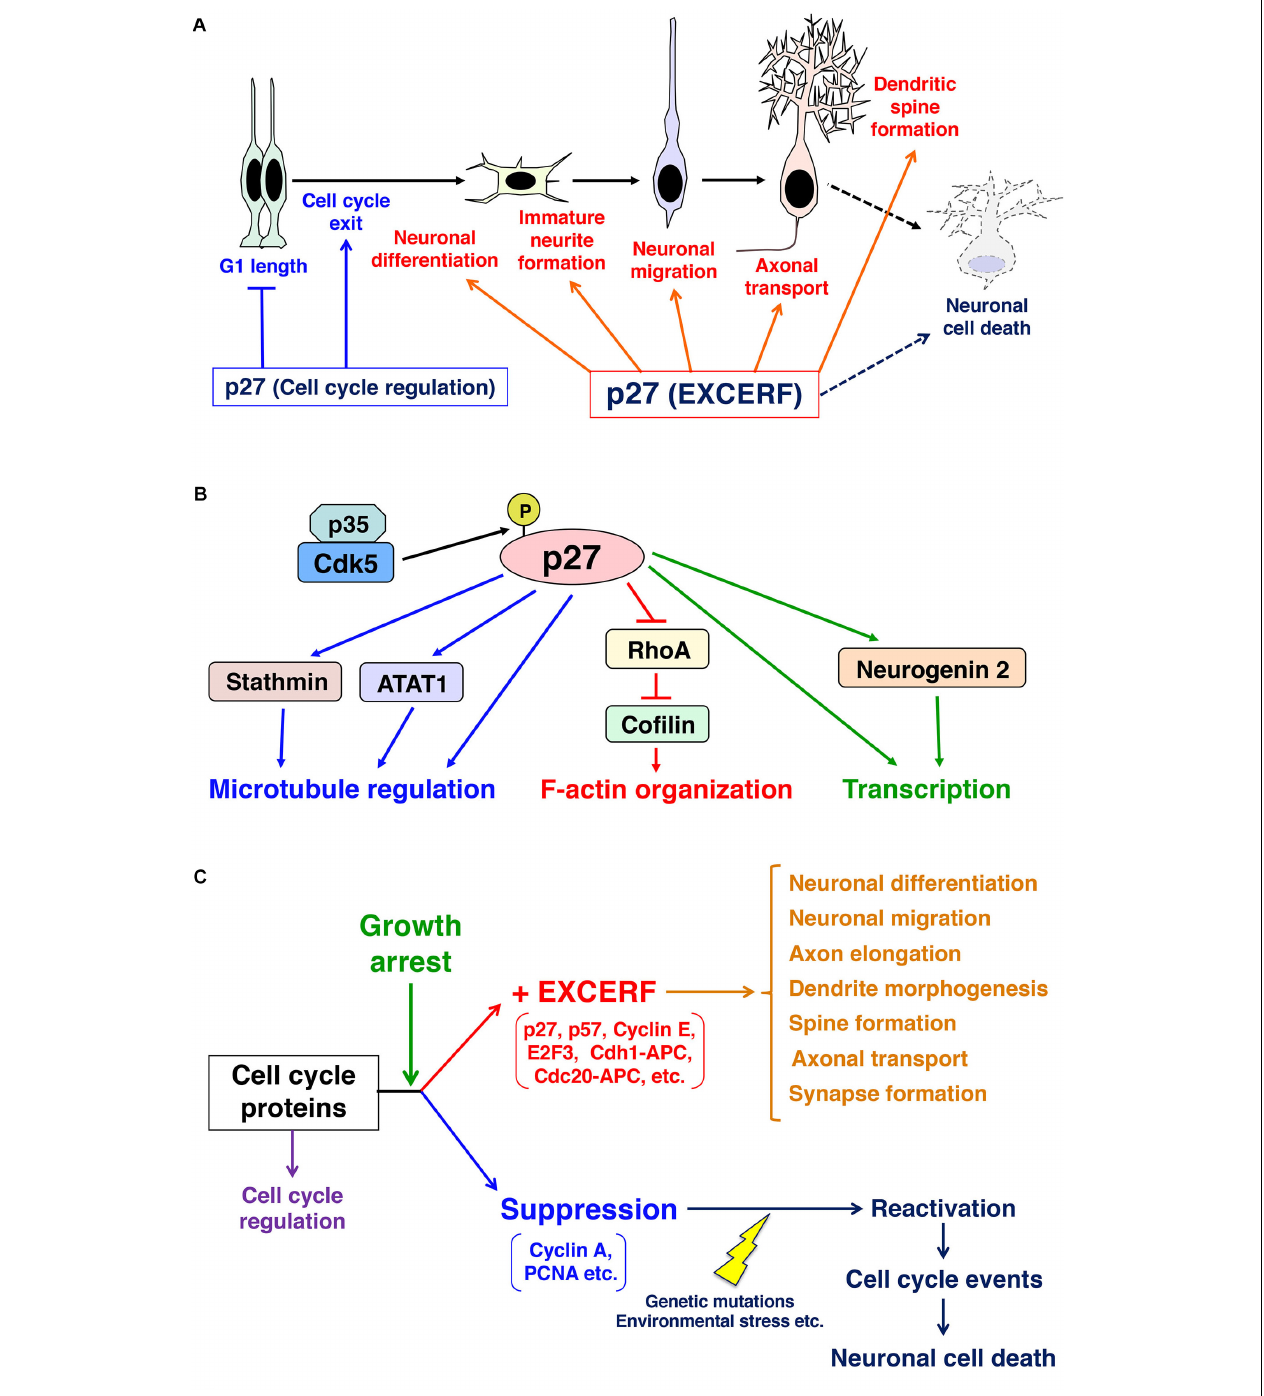
FIGURE 1 | Schematics depicting the roles of p27 in mitotic neural progenitors and post-mitotic neurons. (A) p27 controls G1 length and cell cycle exit in neural progenitors. In addition, p27 exhibits many extra-cell cycle regulatory function (EXCERF) in growth-arrested neurons. p27 promotes immature neurite formation, neuronal migration and axonal transport. p27 is also required for dendritic spine maturation and long-term memory in adult hippocampus. (B) p27 regulates actin reorganization through the suppression of RhoA and the activation of an actin-binding protein, cofilin. p27 also interacts with microtubules and ATAT1 to control microtubule organization and axonal transport, respectively. (C) In post-mitotic cells, cell cycle proteins select two different fates. In general, cell cycle-related proteins, such as cyclin A and PCNA, are suppressed after cell cycle exit and the re-activation of these proteins in growth arrested cells induces cell cycle events, which are priming events to cell death. In contrast, accumulating evidence indicate that other cell cycle-related proteins, including p27, p57, and cyclin E, maintain their expression levels after growth arrest. Growth arrest may switch on extra-cell cycle regulatory functions (EXCERFs) in these proteins.